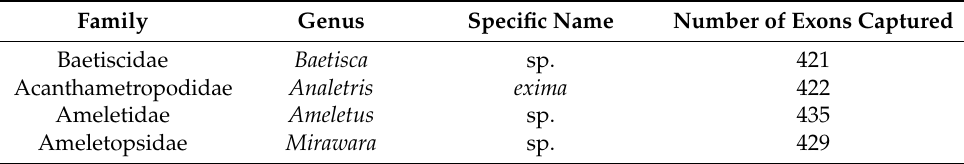
Figure 4. Maximum likelihood analysis of the combined 5-gene Sanger dataset + phylogenomic DNA12 dataset. Results strongly support the monophyly of Coloburiscidae, highlighted in green. The blue circles indicate the nodes that were supported with >70% posterior probability in the Bayesian analysis. The numbers on the nodes are SH-aLRT support %/ultrafast bootstrap support %. Table 2. Taxon sampling for 5-gene Sanger and phylogenomic